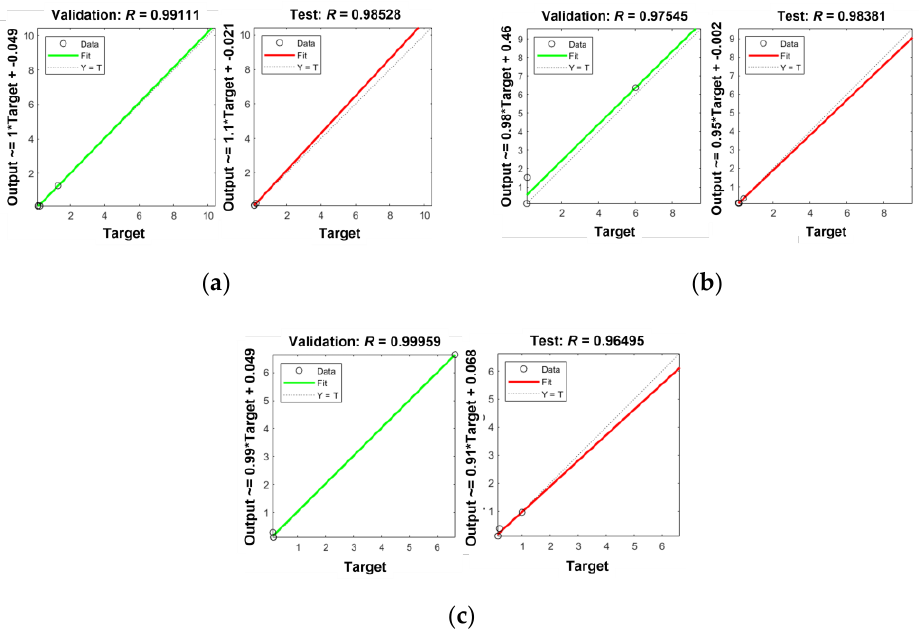
Figure A8. Correlation plots for NN-PSO simulations of NPI for ( a ) TW, ( b ) GW, and ( c ) WRS.